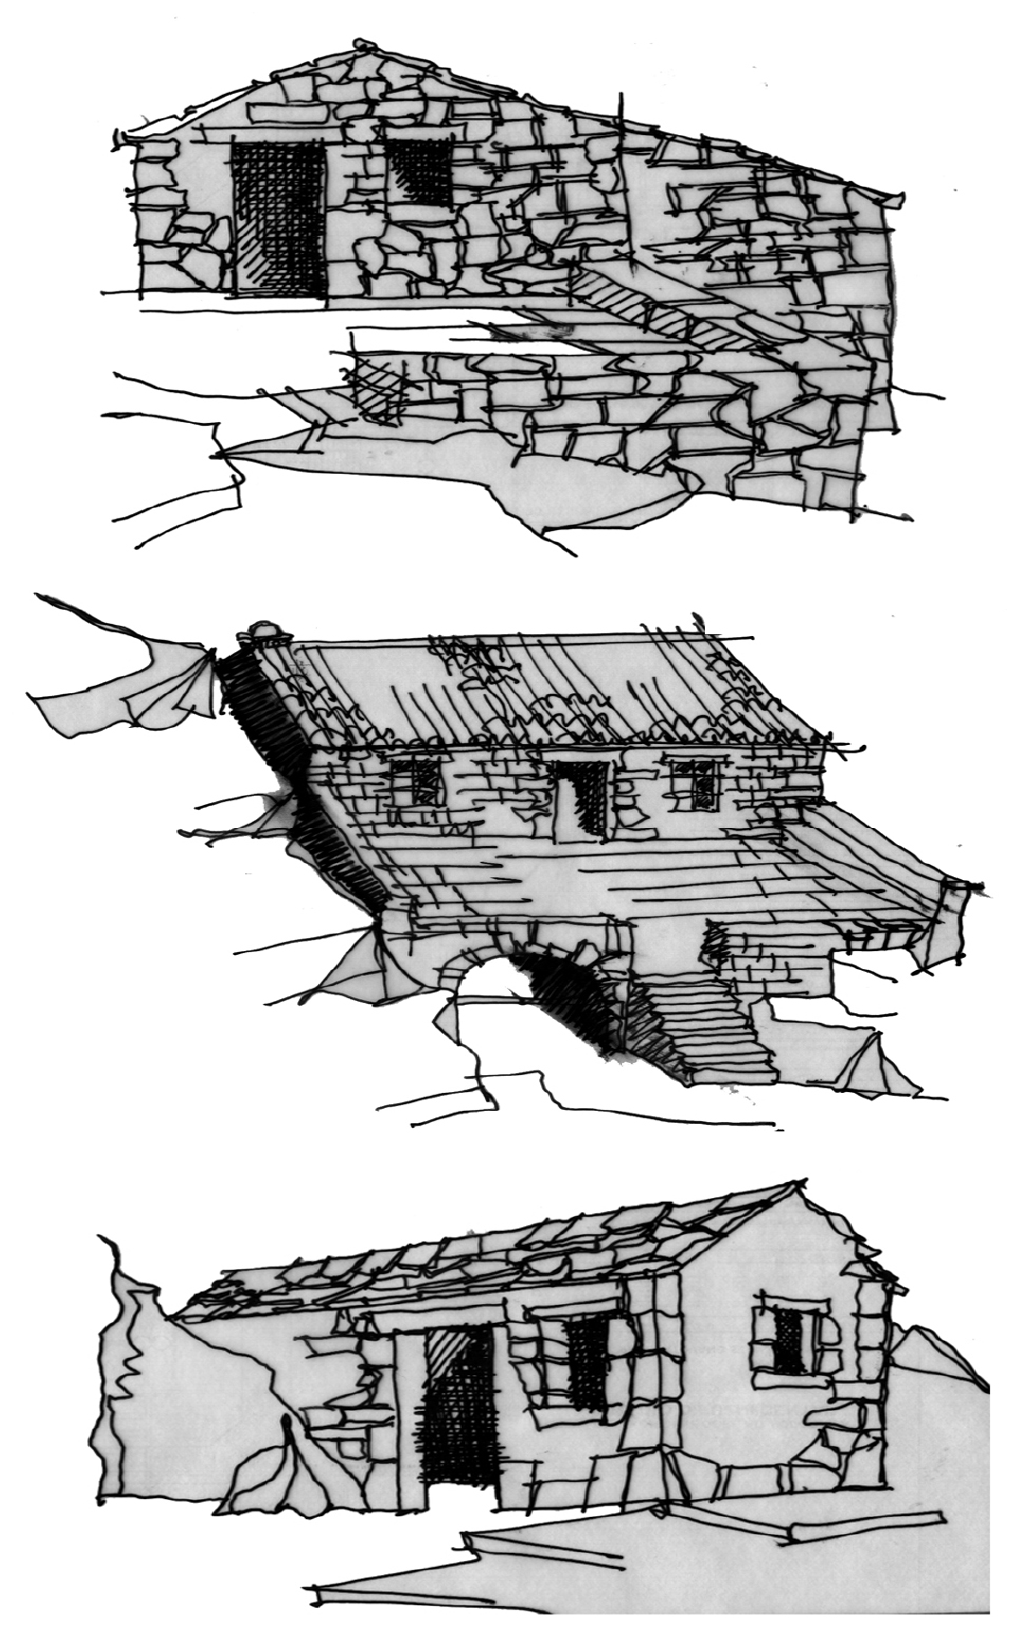
Figure 22. Drawing of Vranjina houses, Zeta region, Montenegro (S. G. Popovic).